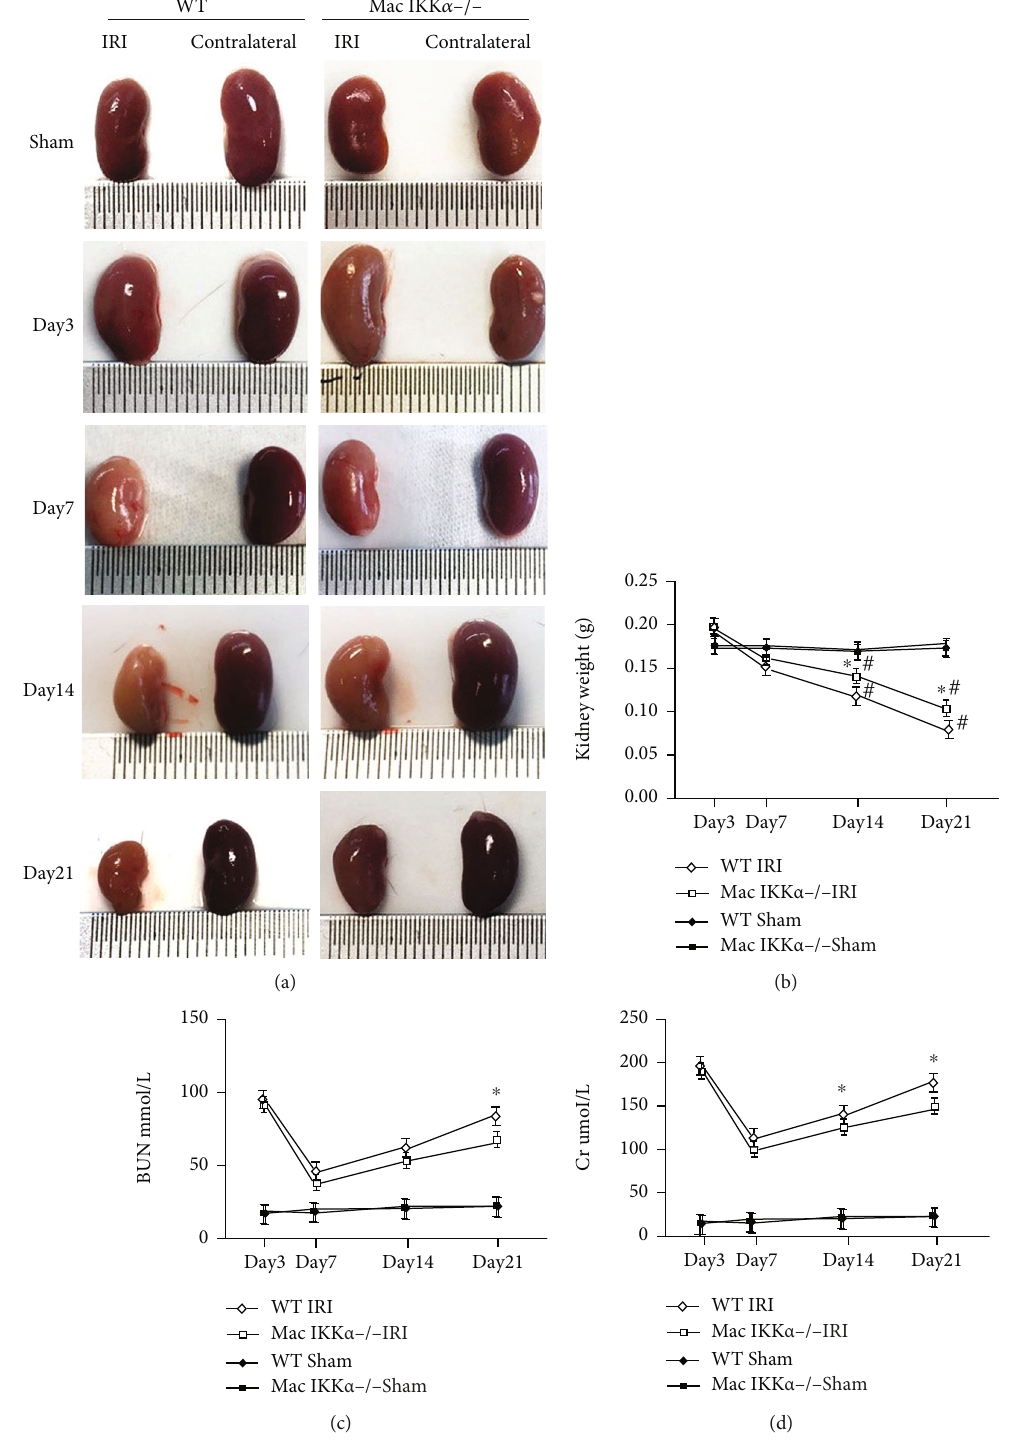
Figure 2: Gross kidney morphology and renal function of WT and Mac IKK α − / − mice after IRI. (a) Gross images of kidneys from WT and Mac IKK α − / − mice at day 3, day 7, day 14, and day 21 after renal IRI. The IRI kidneys of WT mice were smaller and atrophic compared with kidneys of Mac IKK α − / − mice after day 7 following renal IRI. (b) The weight of injured kidneys indicated the extent of atrophy, and the data showed that the kidneys of WT mice were signi fi cantly lighter than the kidneys of Mac IKK α − / − mice. (c, d) Creatinine and urea nitrogen levels in serum were measured 1 day after contralateral nephrectomy at the indicated time points. Data are presented as the mean ± s : d . ∗ P < 0 : 05 versus Mac IKK α − / − mice; # P < 0 : 05 versus sham-treated mice of the same genotype; n = 4 -6, two-way